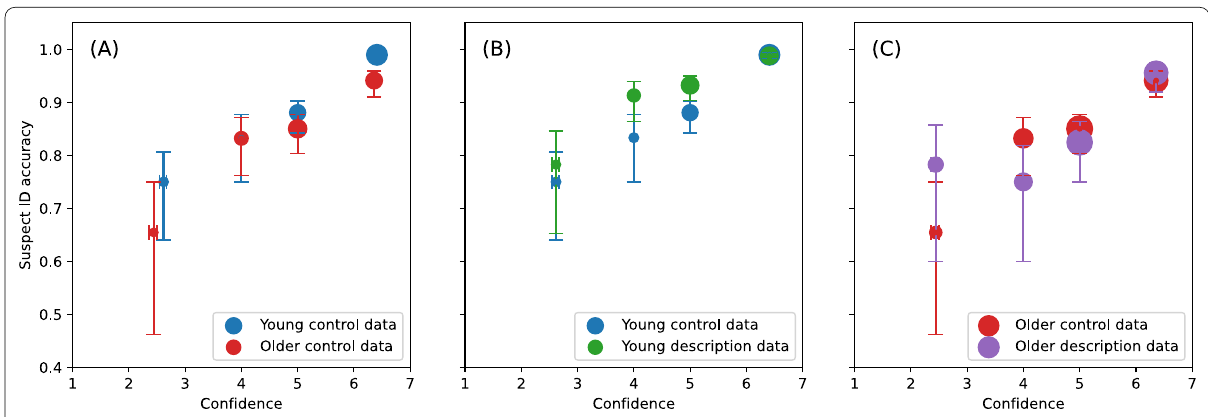
Fig. 2 CAC curves showing data for 4 levels of confidence: high confidence (rating of 6 and 7), medium–high confidence (rating of 5), medium– low confidence (rating of 4), and low confidence (rating of 3, 2, and 1) for the A young and older group for the control condition, B control and experimental conditions for the young group, and C control and experimental conditions for the older group. The size of each data point represents the relative frequency of the response. The error bars plot 68% bootstrap confidence intervals, which are the bootstrap equivalent of